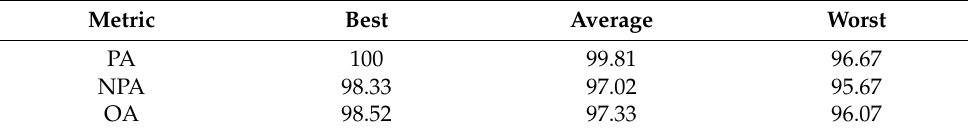
Table 5. Unauthorized PV detection result by proposed method.